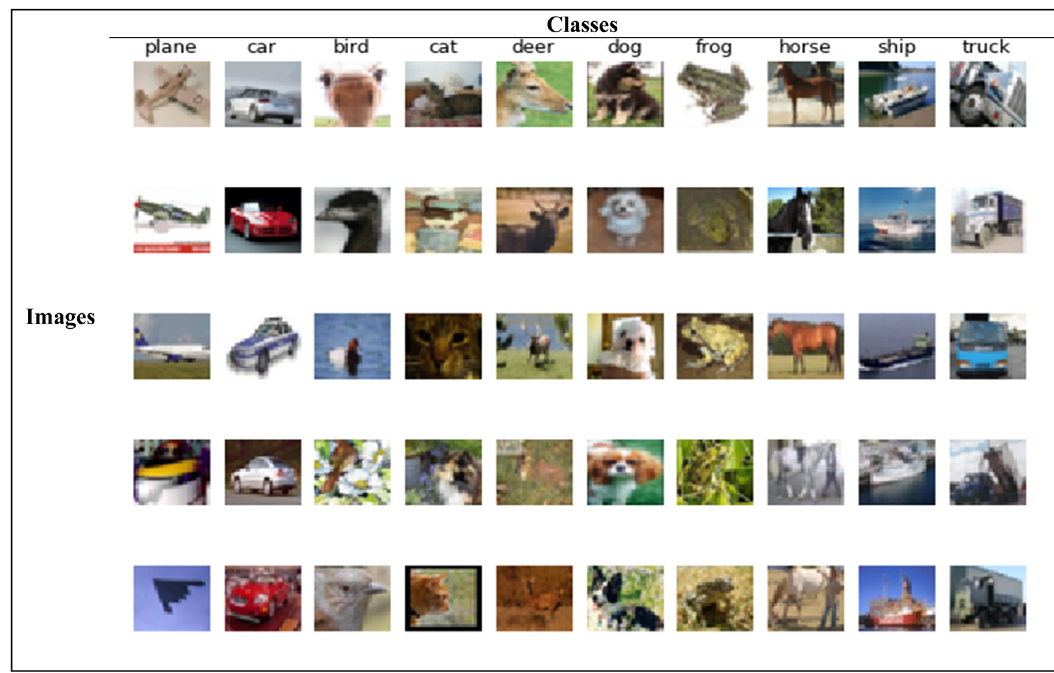
Figure 3: CIFAR - 10